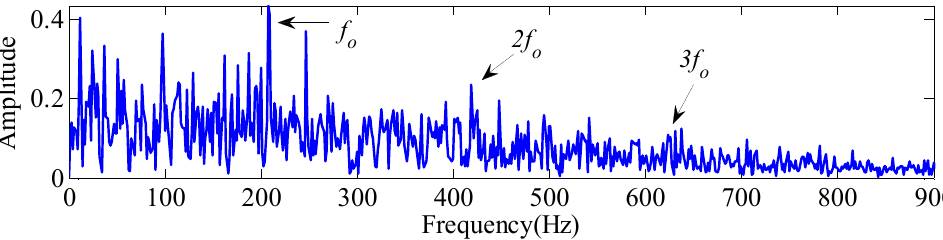
Figure 28. The noise reduction envelope spectrum of the signal segment selected by the algorithm in this paper.